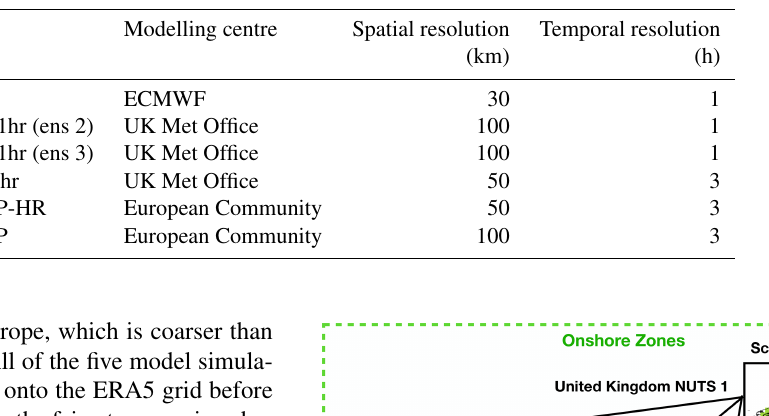
Table 1. Details of climate models used in this dataset.